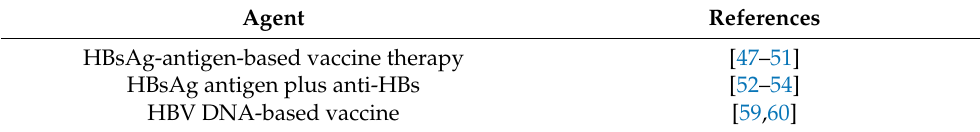
Table 3. HBV antigen-based immune